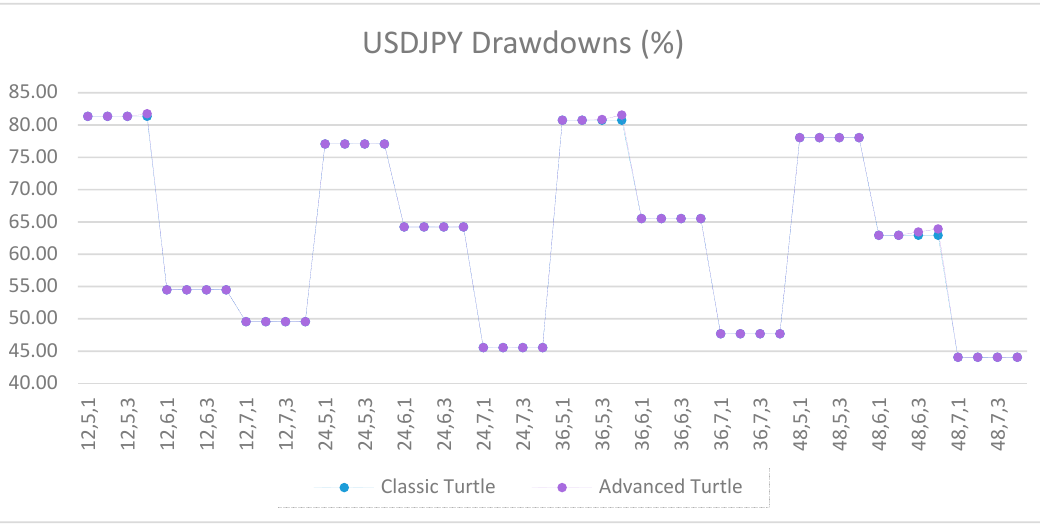
Figure A58. Drawdowns of USDJPY as percentage of equity between the classic and the advanced Turtle systems for every combination of N, X, Y for the slow parameters (80, 160), where X ≥ 5.